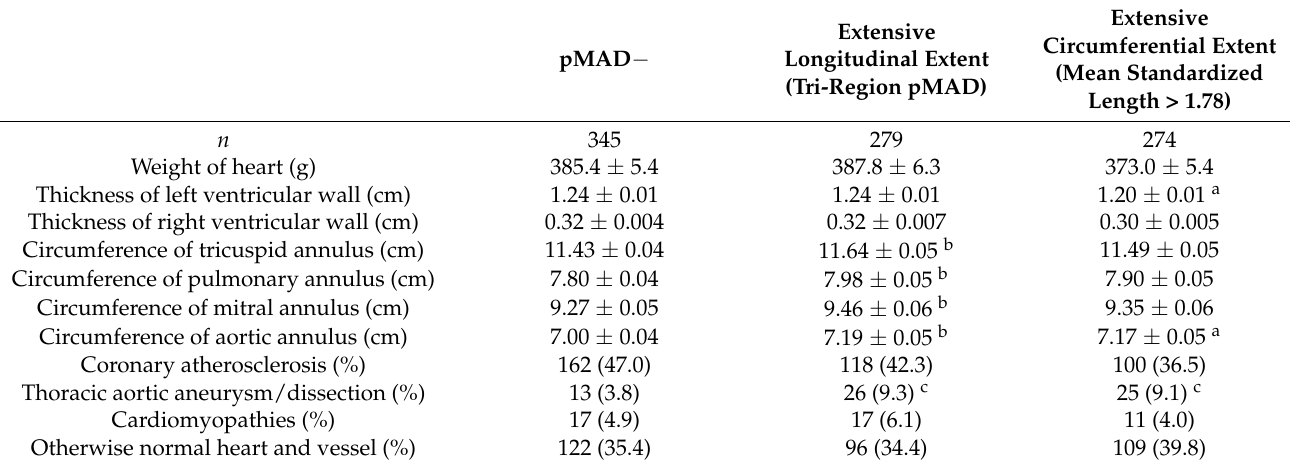
Table 3. Morphological changes in the extensive longitudinal or circumferential extent of